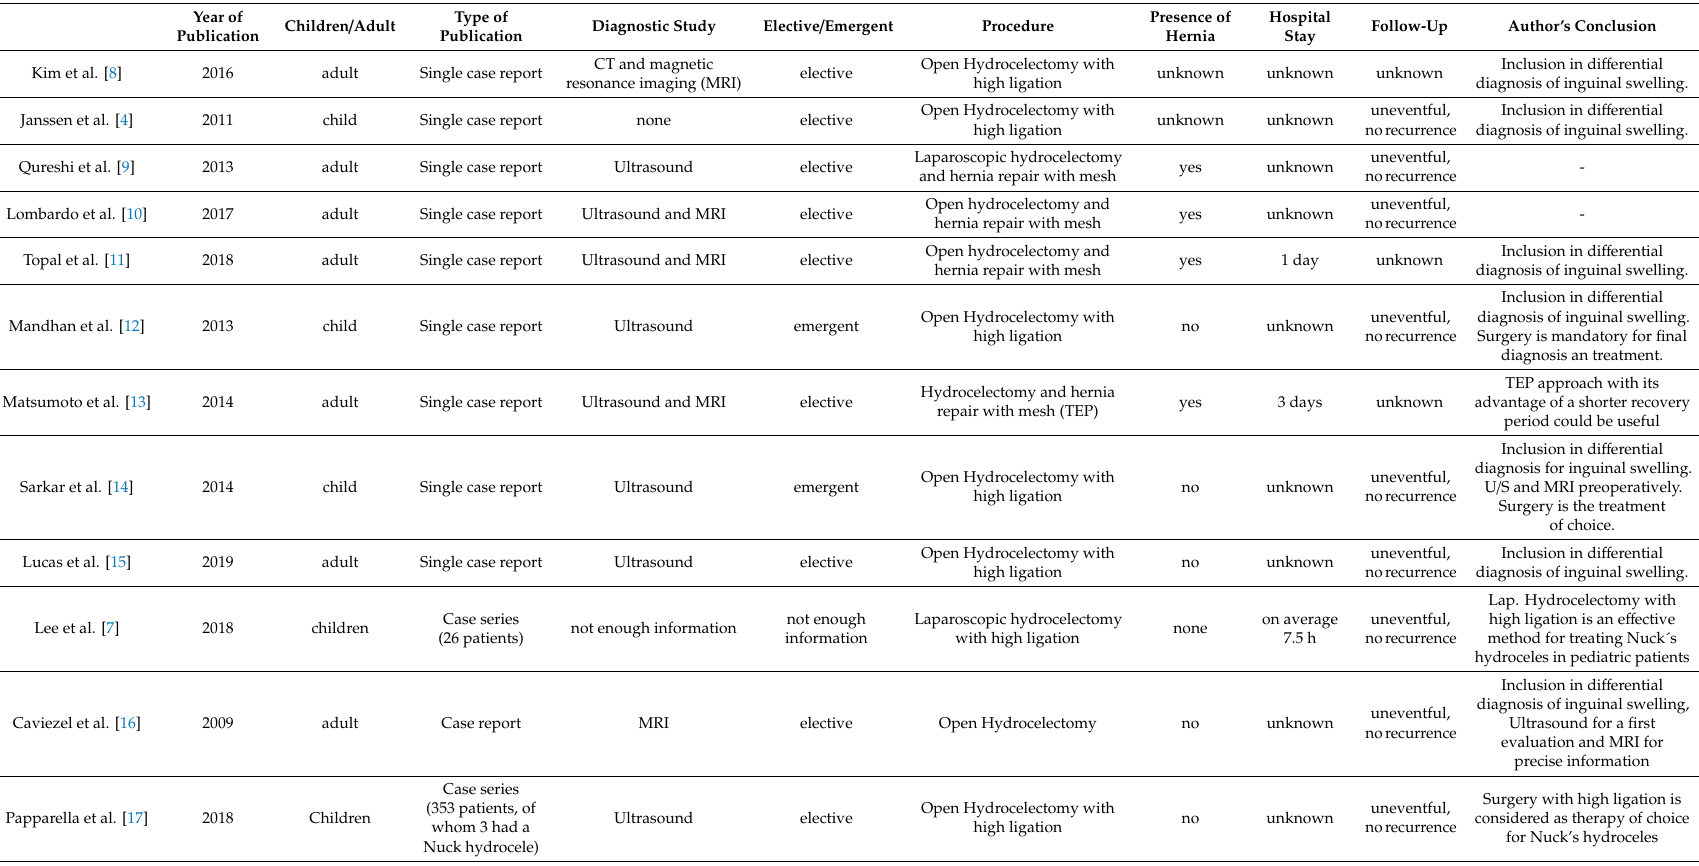
Table 2. Comparison of the literature referring to Nuck hydroceles with surgical